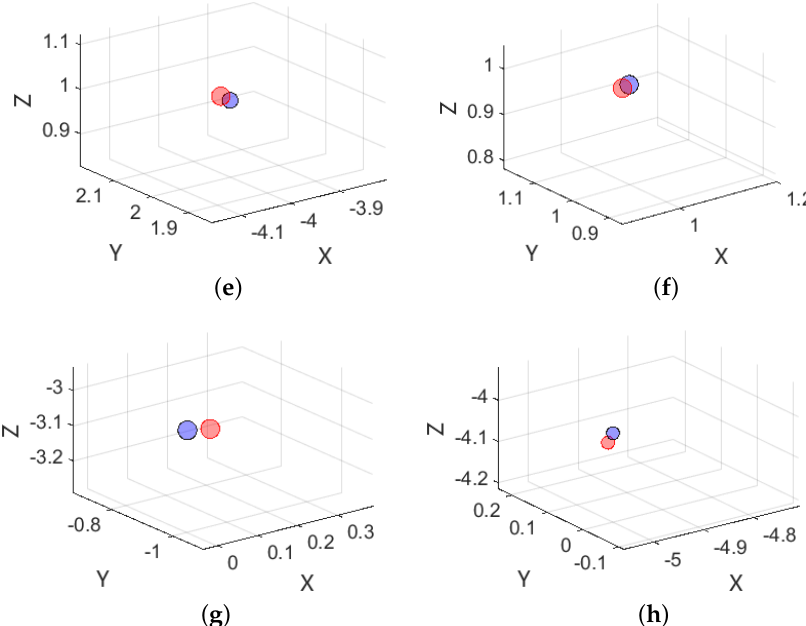
Figure 5. The reconstructed effect of the location and magnitude of a single source is plotted. The size of the points represents the module of the magnitude of the source, the blue points represent the real information of the source, and the red points represent the reconstructed information of the source. Each subplot represents the reconstruction result of different points. ( a – d ) are the reconstruction of the location and magnitude of the source in 2D, and ( e – h ) are the reconstruction of the location and magnitude of the source in 3D.